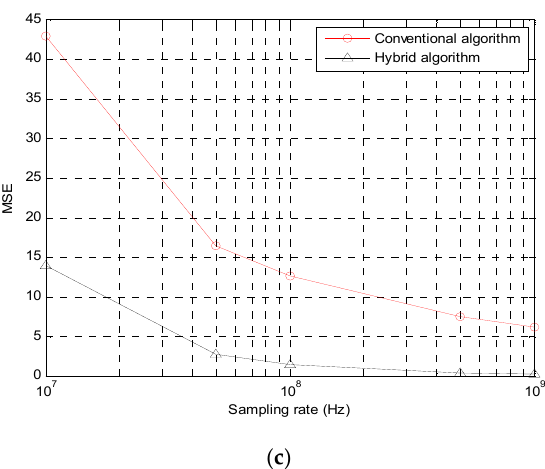
Figure 14. MSE curves for the estimated MS locations based on the proposed hybrid algorithm and the conventional algorithm, of the first scenario for ( a ) the first case, ( b ) the second case, and ( c ) the third case, for the second set.